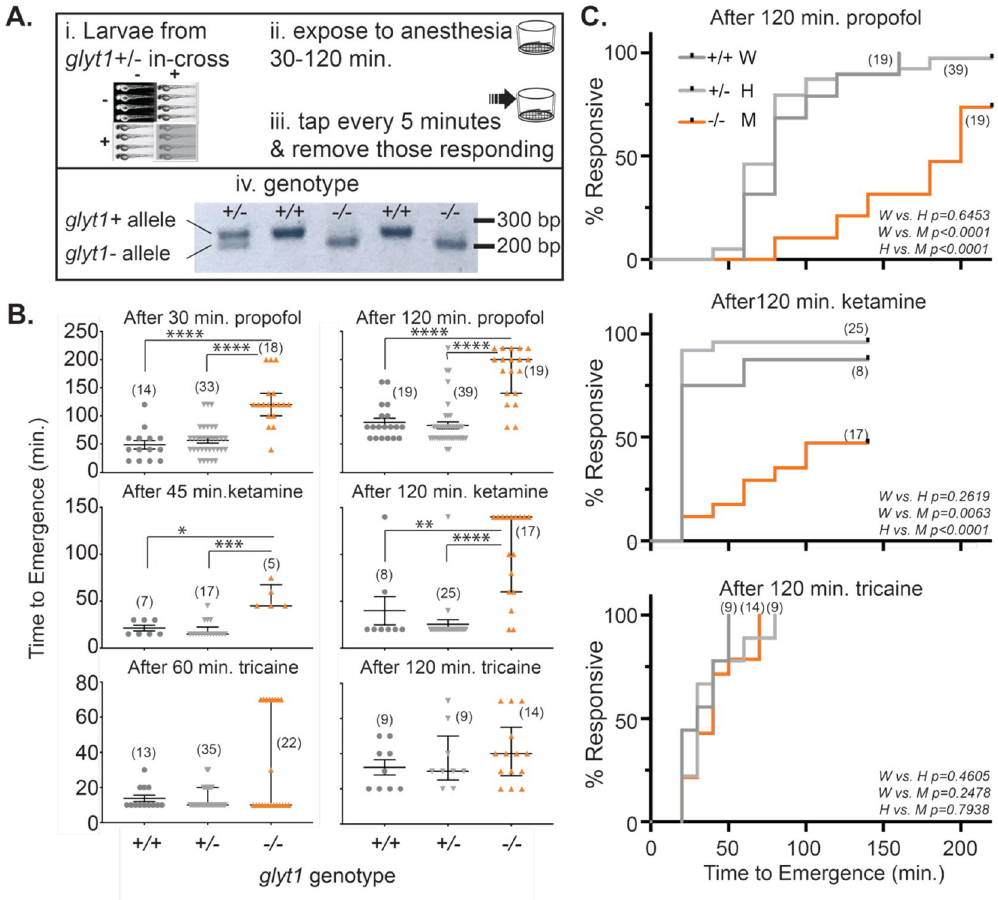
Figure 3. glyt1−/− mutant zebrafish larvae show delayed emergence from anesthesia. ( A ) Experimental workflow is indicated. i-Progeny from glyt1 ± adult in-cross were raised for five days and ii-transiently exposed to one of three anesthetics:10 µM propofol, ketamine (20 mM 45 min. or 10 mM 120 min.) and buffered 765.4 µM tricaine. iii-After removal of anesthetic, time of first response to vibration (stimuli were delivered at five-minute intervals) was recorded and iv-individual genotypes were subsequently determined using a PCR/restriction enzyme-based assay. A representative, cropped image of the genotyping gel with each lane corresponding to a larvae is shown. ( B ) Scatter plots of individual emergence times are overlaid with median and interquartile range. Kruskal Wallis ANOVAs followed by Dunn’s multiple comparisons were conducted for each anesthetic and incubation time. Asterisks indicate p -value: * p < 0.05, ** p < 0.001, *** p < 0.001, **** p < 0.0001. Compared to their siblings, glyt1−/− mutants took more than twice as long to emerge from both ketamine and propofol. By contrast, glyt1−/− mutants and their siblings took similar amounts of time to emerge from tricaine. ( C ) Kaplan–Meier plots of the proportions of responsive fish against time-post-anesthesia for the same glyt1 + / + , glyt1 + /- , and glyt1−/− larvae presented in B are shown post-120-min exposures to propofol (top), ketamine (middle), and tricaine (bottom). p -values are calculated using log rank